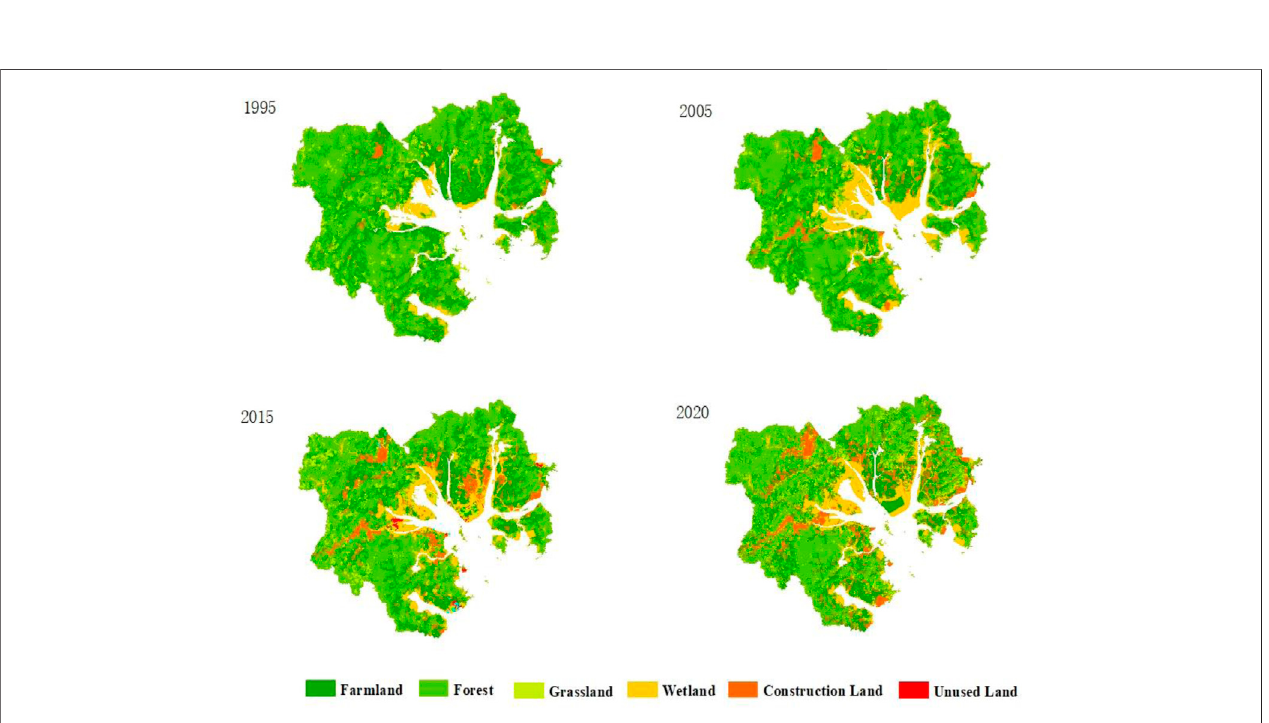
FIGURE 3 | Diagram of processing remote-sensing